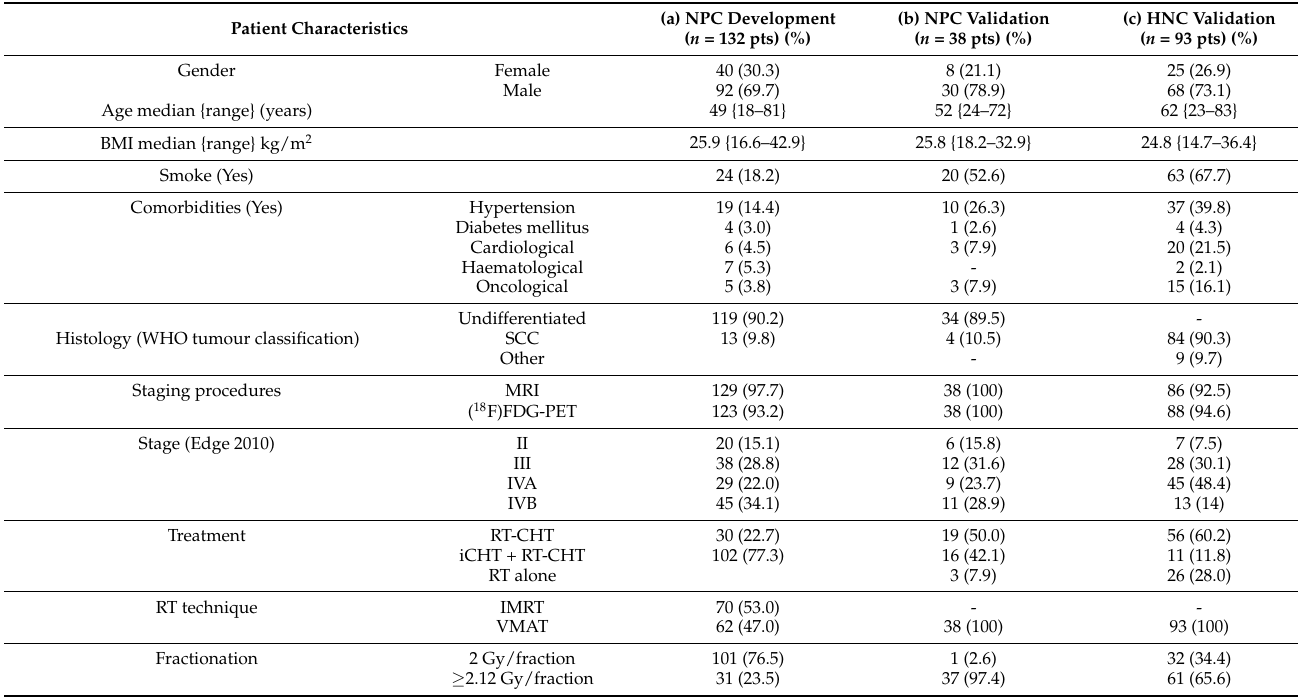
Table 1. Patient and treatment characteristics for the three cohorts considered in the study: (a) Nasopharyngeal Cancer (NCP) patients for model development; (b) NPC patients for model validation and (c) mixed head and neck cancer (other than NPC) validation